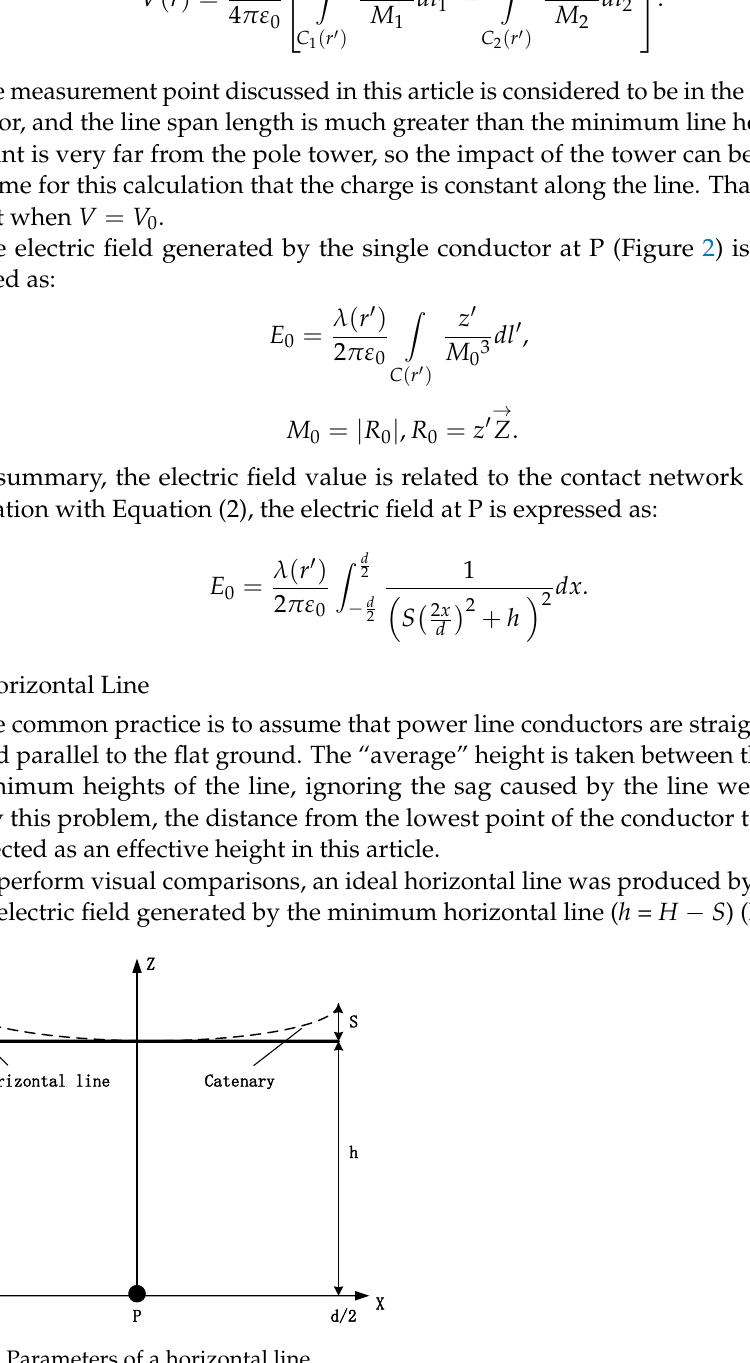
Figure 3. Parameters of a horizontal line.